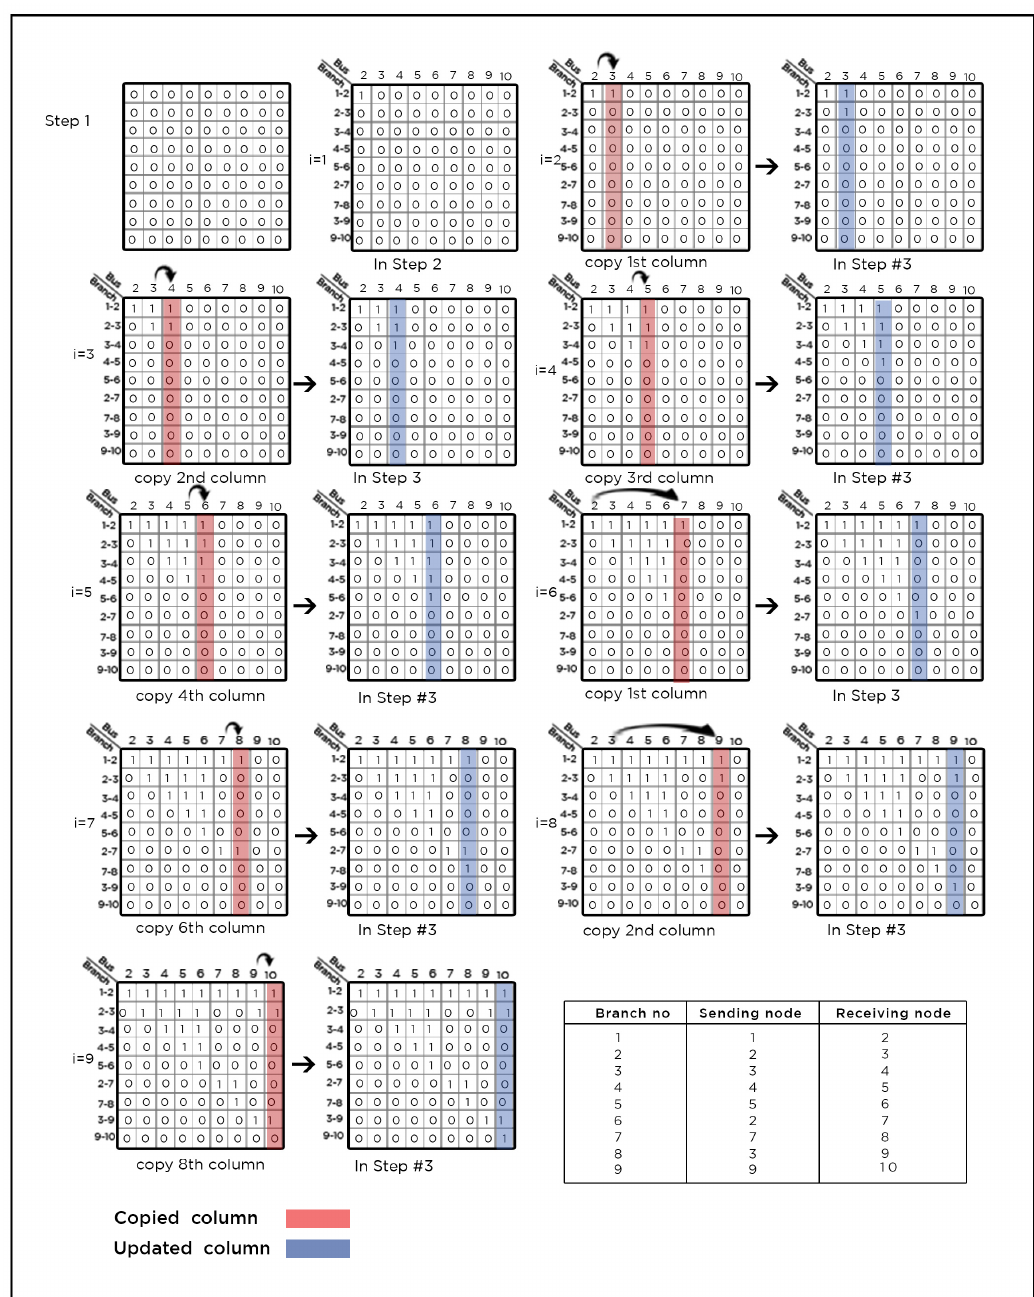
Figure 9. The formation of BIBC matrix using the simple distribution system.